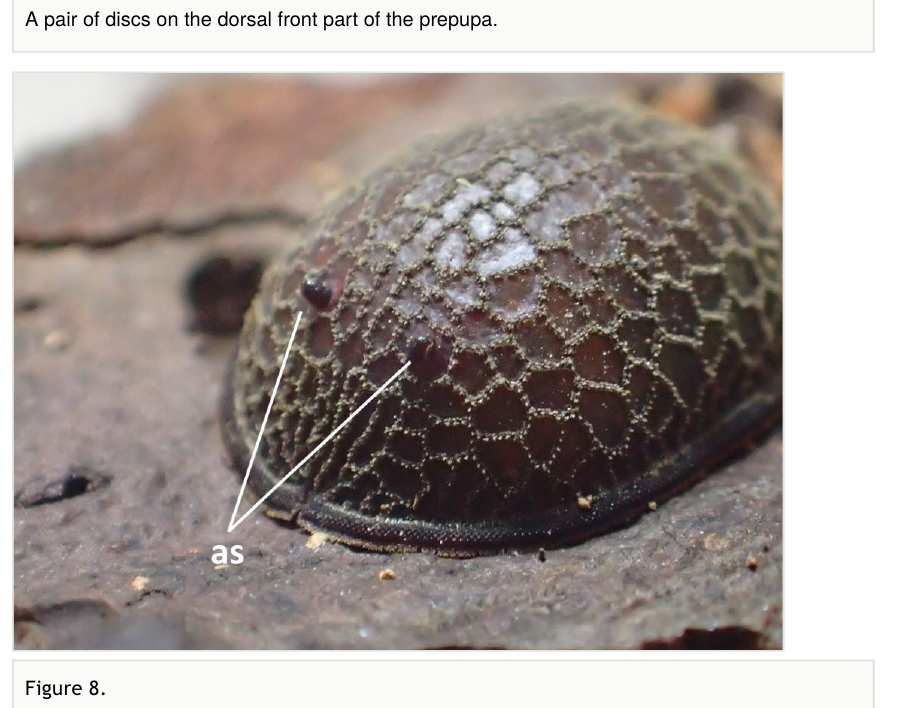
Figure 8. A pair of anterior spiracles (as) protruded from the